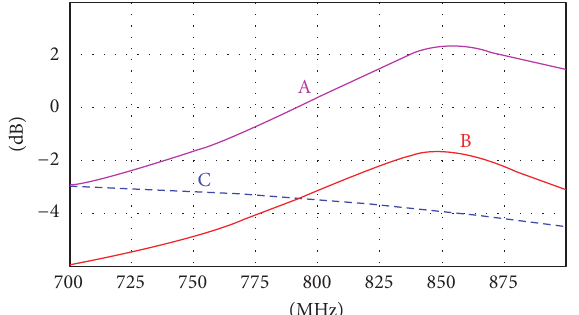
Figure 18: Insertion gain (curve A), transducer power gain (curve B), and mismatch factor without the antenna tuner (curve